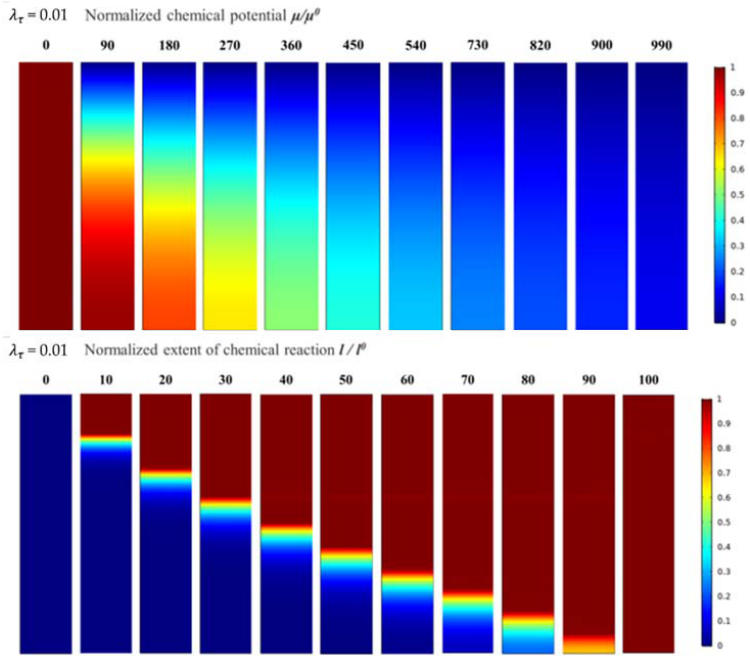
Figure 6. The evolution process for normalised chemical potential and normalised chemical reaction degree when λ (cid:2980) = 0.01. Figure 7 shows the evolution curves of the normalised chemical potential and normalised chemical reaction degree when λ (cid:2980) equals 0.01. Compared with the evolution curves of the normalised chemical potential when λ (cid:2980) equals 1 and 0.1, the evolution process is still quite similar. From the evolution curves of the normalised chemical reaction degree, the water vapour corrosion rate of the EBC system remained the same in the second half of the time span. In the initial period of the corrosion process, the corrosion rate was relatively fast, but the effect was not evident. Further, the change in the degree of the chemical reaction between the un-corroded and corroded area was relatively high; the front of the corrosion reaction was significantly evident, and the transition area was approximately 10% of the entire EBC system.